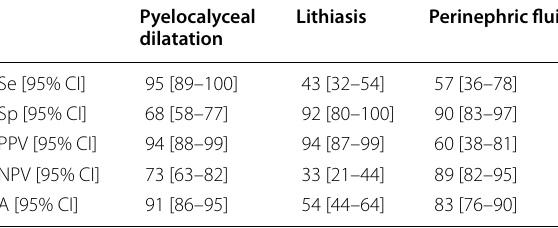
Se, sensitivity; Sp, specificity; PPV, positive predictive value; NPV, negative predictive value; A, accuracy